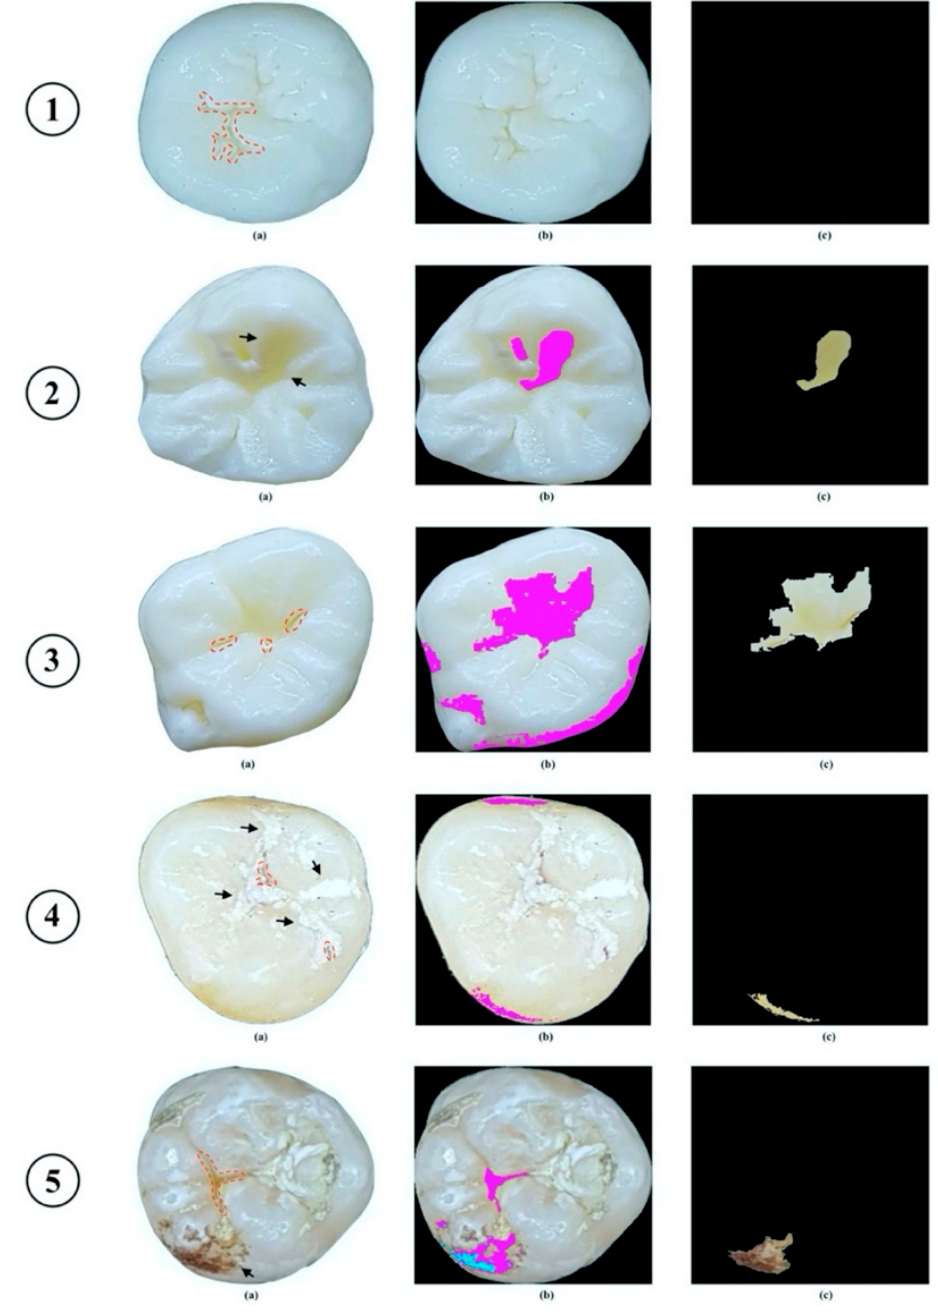
Figure 5. Examples of failures on caries detection (presence of confounding factors on occlusal surfaces were indicated by black arrows). ( a ) Carious lesion area was identified by the experts; ( b ) carious lesion area was identified by proposed method; ( c ) extracted carious lesion area.